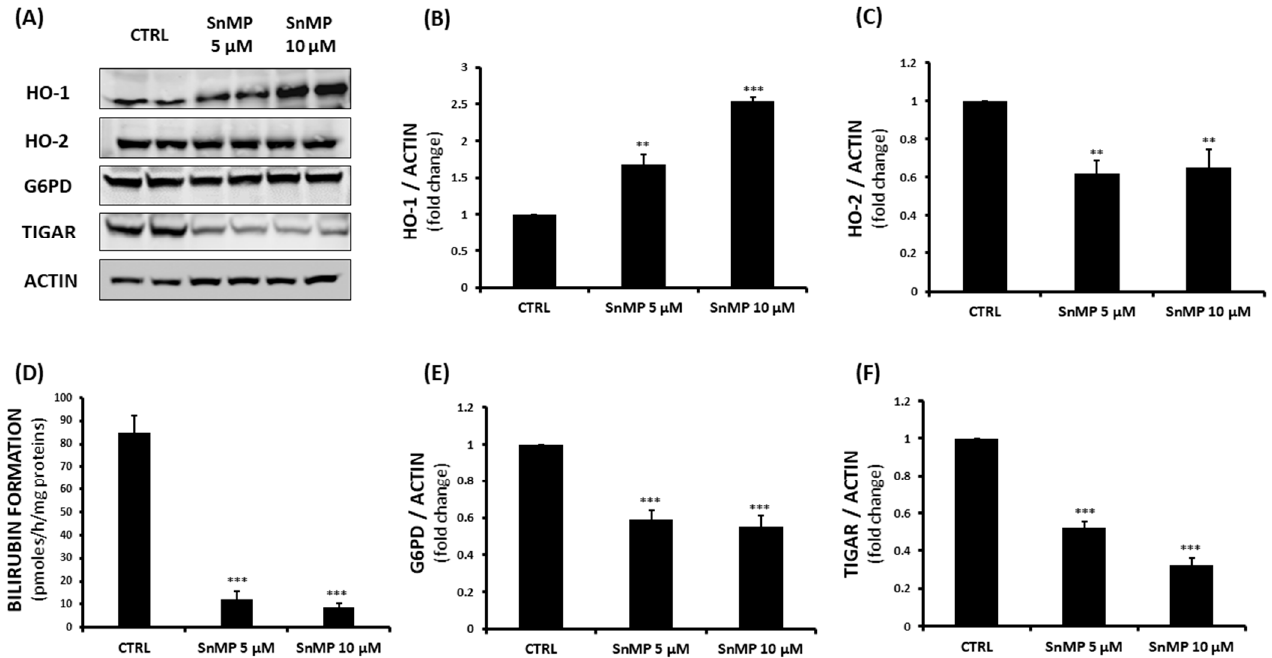
Figure 2. ( A – C , E , F ) Evaluation of SnMP (5 µ M, 10 µ M) effects on HO-1, HO-2, G6PD and TIGAR protein levels on A549 cells. ( D ) Measurement of HO enzymatic activity in A549 cells after 5 µ M and 10 µ M SnMP treatment (** p < 0.01, *** p < 0.001 vs. CTRL). Results are expressed as mean ± SEM.